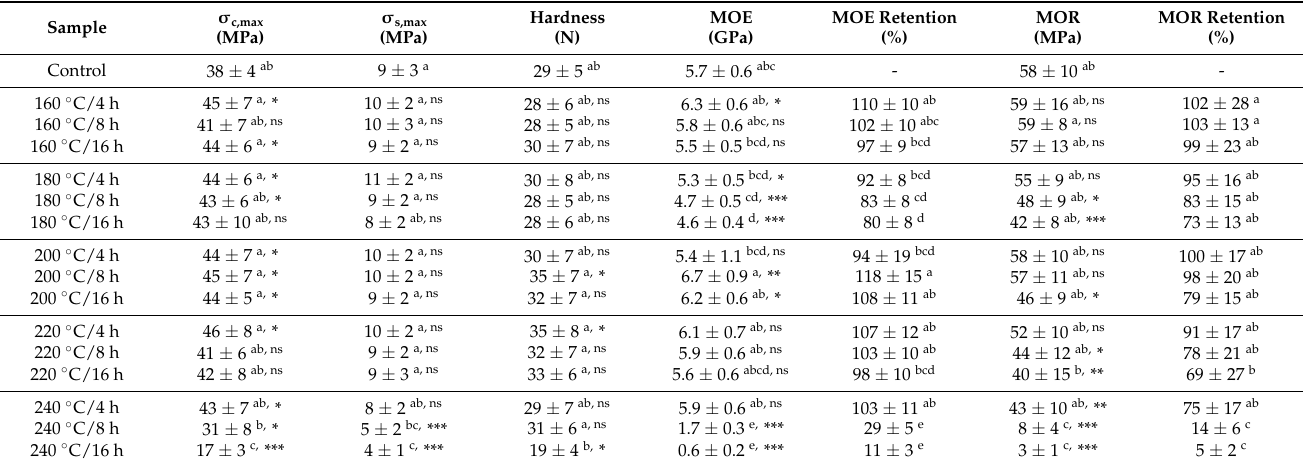
Table 1. Compressive strength ( σ c,max ), shear strength ( σ s,max ), hardness, MOE, and MOR of un- treated and VH-treated luanta fir